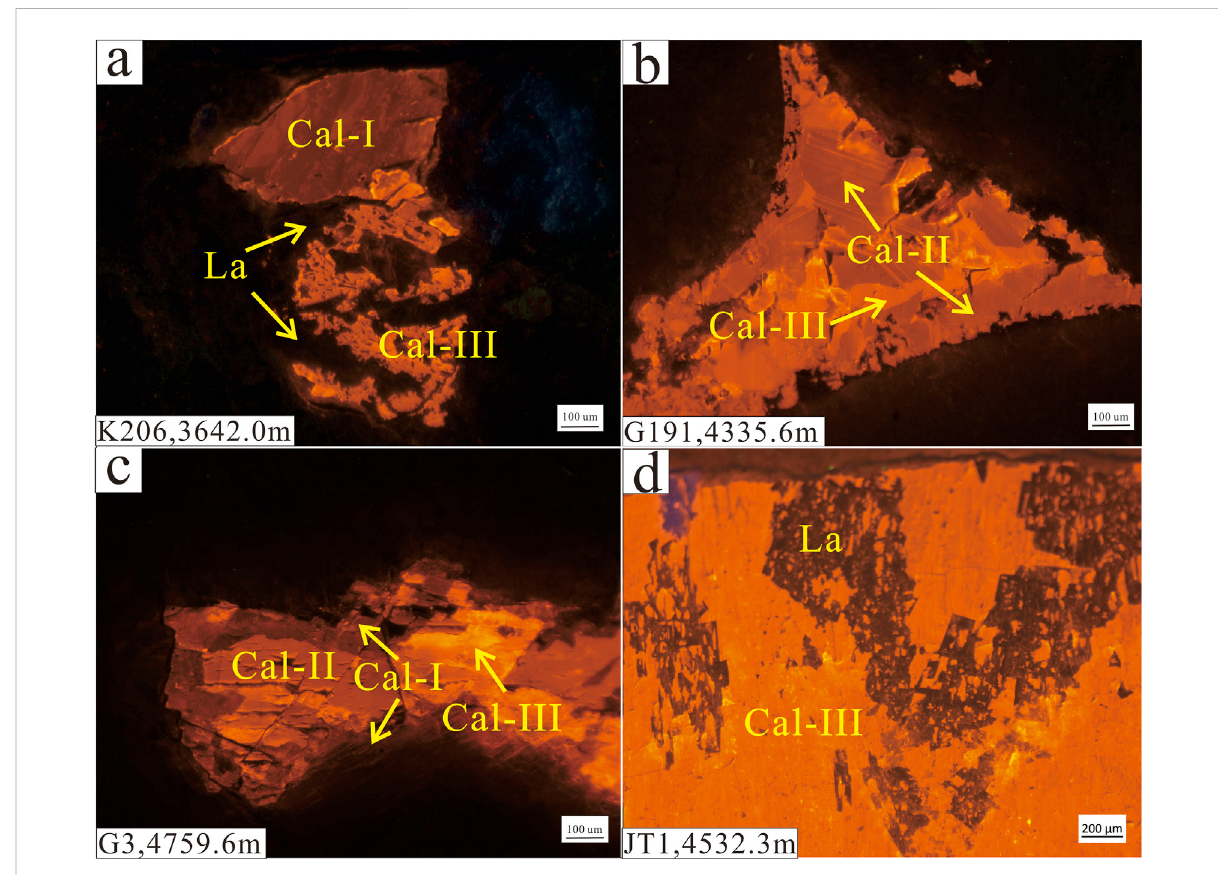
FIGURE 4 CLimagesofintergranularcalcitecementinasandyconglomeratefromtheP 3 w Formation. (A) Gray fi ne-grainedconglomeratefromawater- bearinglayer. (B) Graysandyconglomeratefromaheavyoil-bearinglayer. (C) Grayconglomeratefromagas-bearing layer. (D) Graysandstonefrom an oil-bearing layer. La: laumontite, Cal-I: early-stage calcite, Cal-II: late-stage calcite I, Cal-III: late-stage calcite